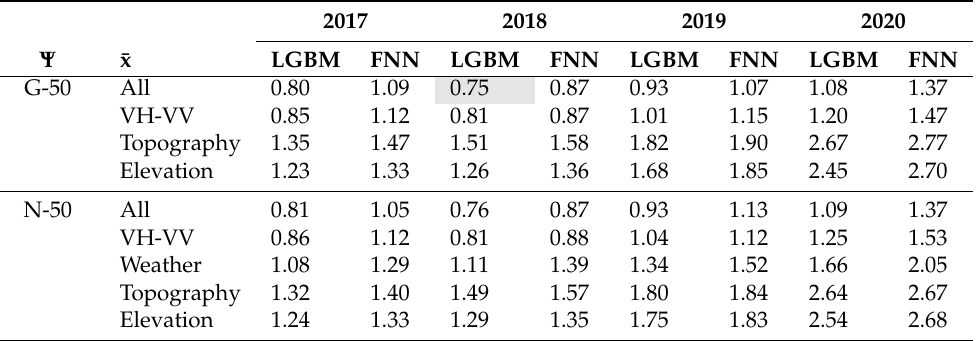
Table 3. RMSE for each year, model, feature vector, sampling method, and resolution. The LGBM model outperforms the FNN model in all cases. There seems to be a slight advantage to using Grid sampling. Note that weather is not presented with the Grid sampling method, since we only sample from one weather station per field.